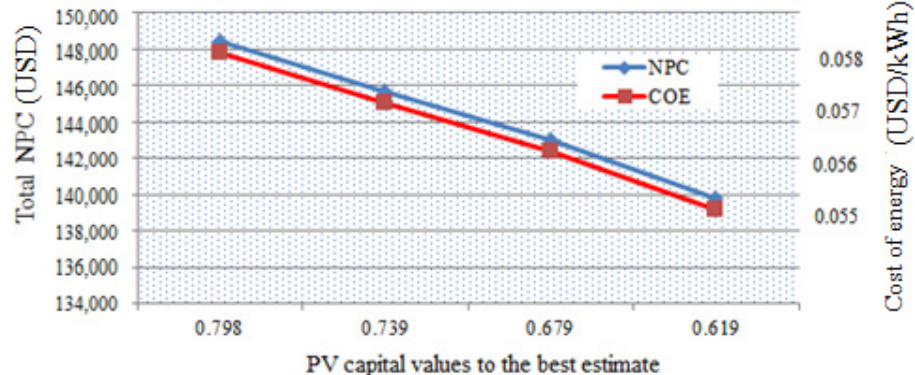
Figure 13. Impact of PV capital cost change on the NPC and COE.